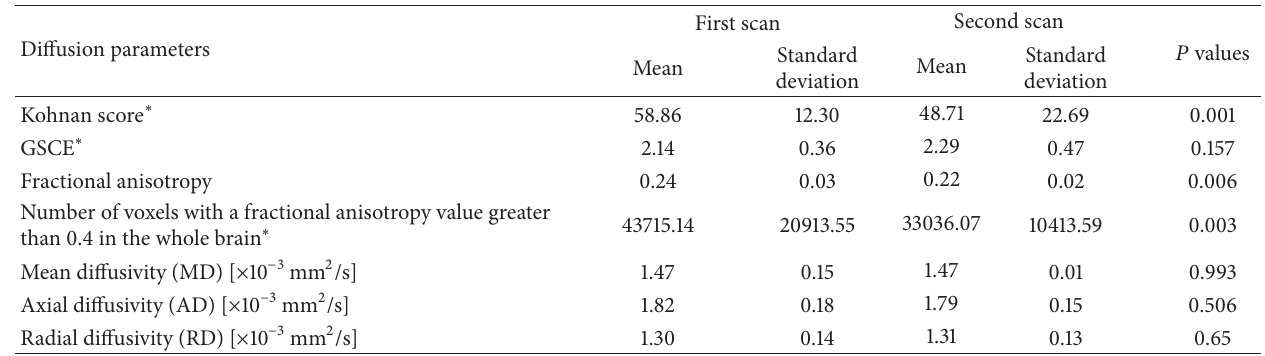
Table 4: Comparison of diffusion tensor parameters and consciousness disorders.